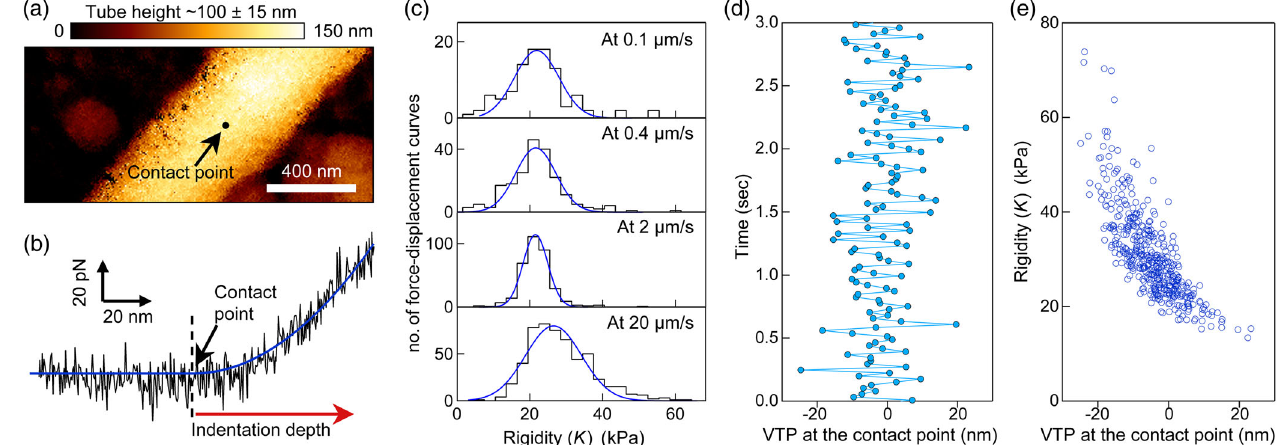
FIG. 2. Multiple force-distance curves collected at a single point of contact on a nanotube. (a) AFM image of a SMC nanotube. The arrow points to where all the force curves analyzed in (b) – (e) are recorded. (b) Example of a force curve recorded at a speed of 2 μ m = s. The blue line is the result of fitting the equation f ¼ K δ 2 to the data and returns the rigidity (here K ¼ 24 kPa). (c) Distribution of K derived from force curves collected at different indentation speeds. Blue lines are Gaussian fits to the data. (d) Time versus vertical tip position (VTP), which indicates the height at which the AFM tip contacts the nanotube during its downward vertical movement. (e) K plotted as a function of the VTP. In this graph K is derived from force curves collected at a speed of 20 μ m =s and it corresponds to the data displayed in (d) and in the bottom graph in